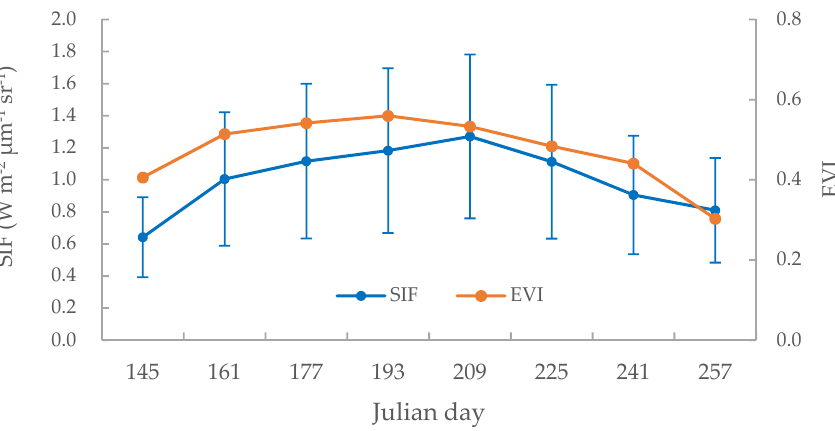
Figure 2. SIF and EVI changes with time in the growing seasons of 2015–2018.